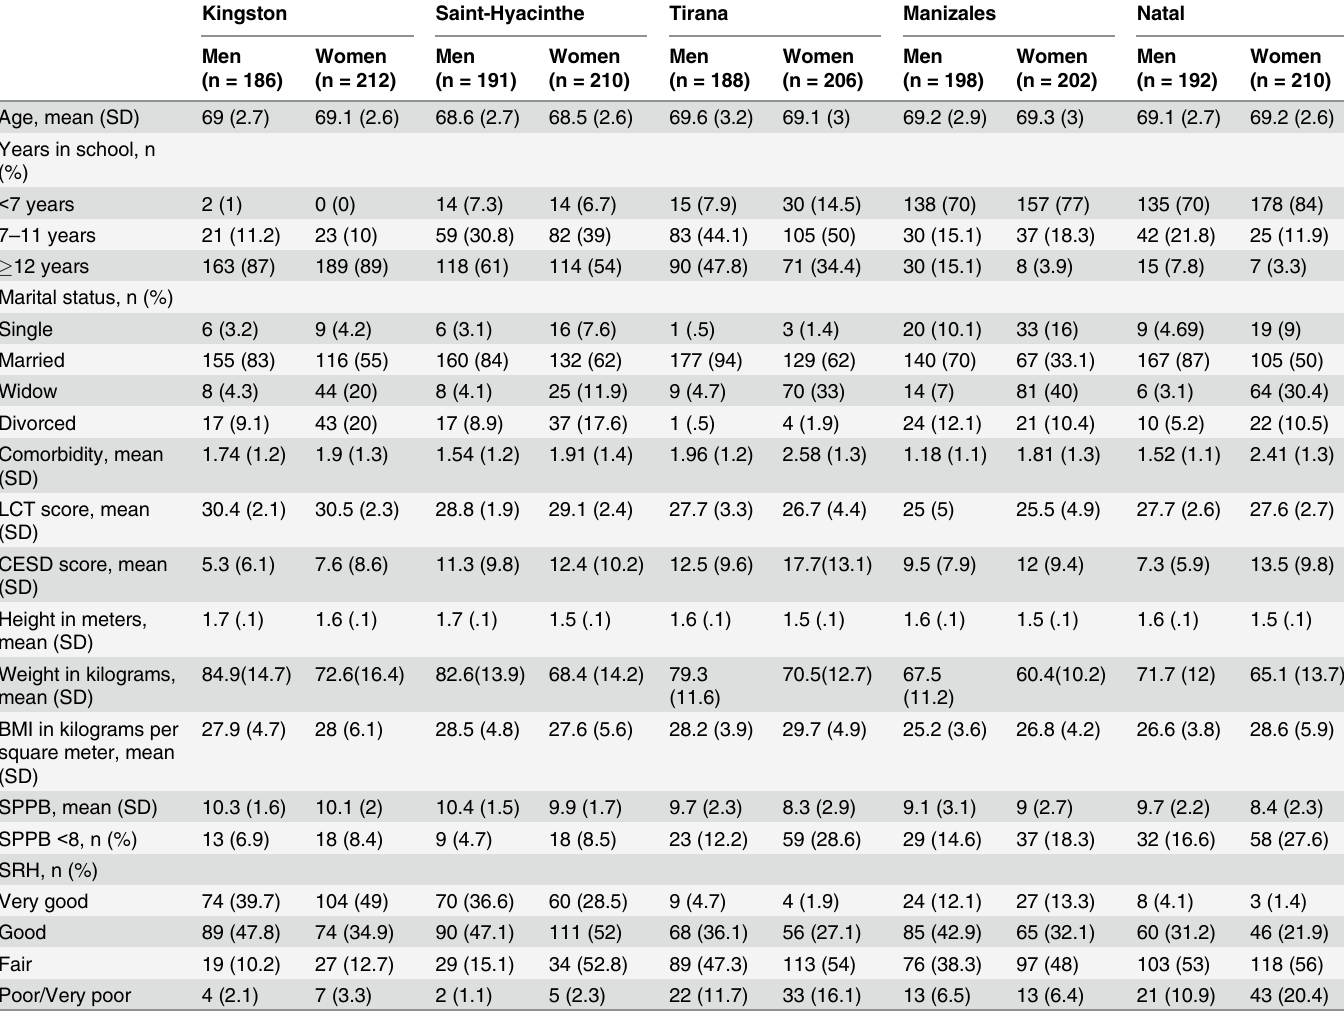
Table 1. General Characteristics of the Sample According to Site and Stratified by